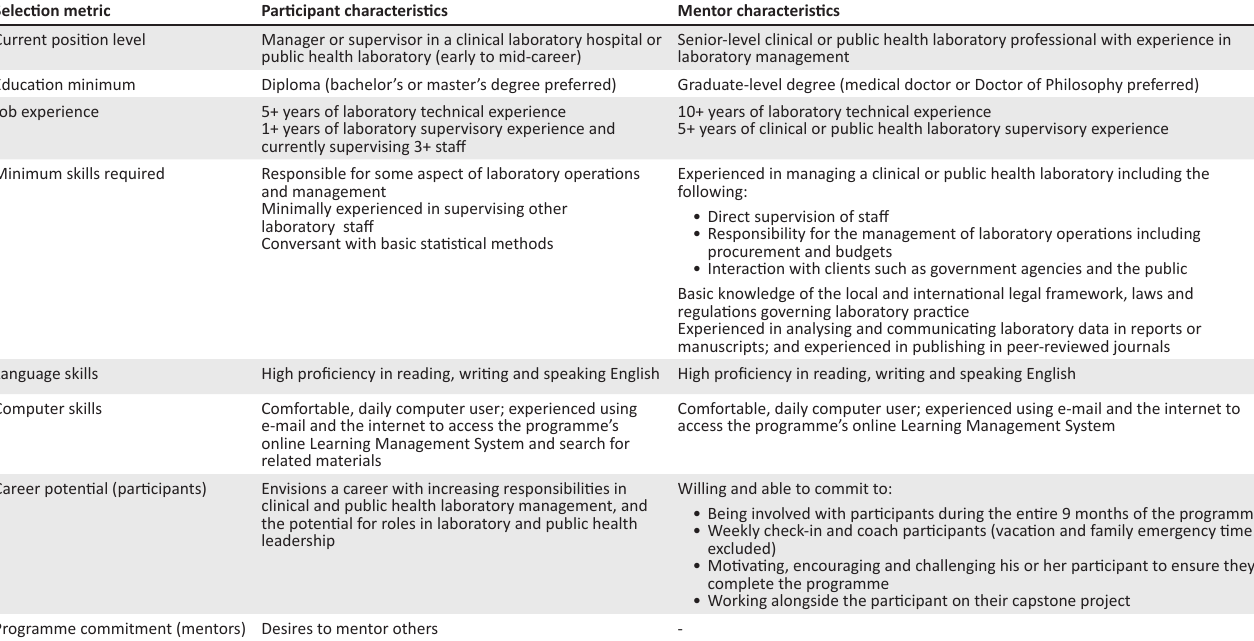
TABLE 1: Participant and mentor selection criteria, Zambia, 2016–2018.